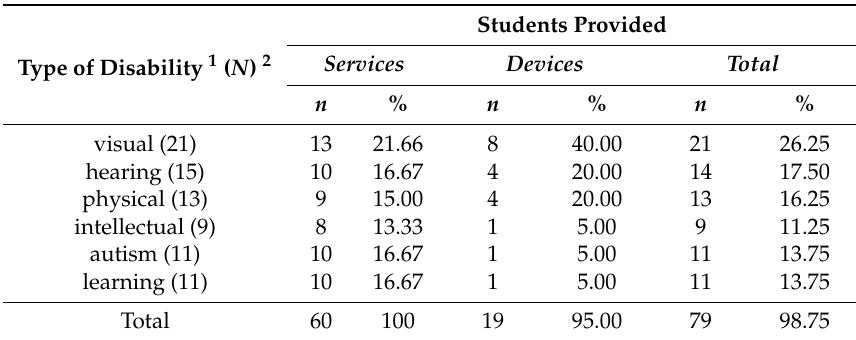
Table 2. Overview of access to information for learning by assistive devices and educational services provided to students with